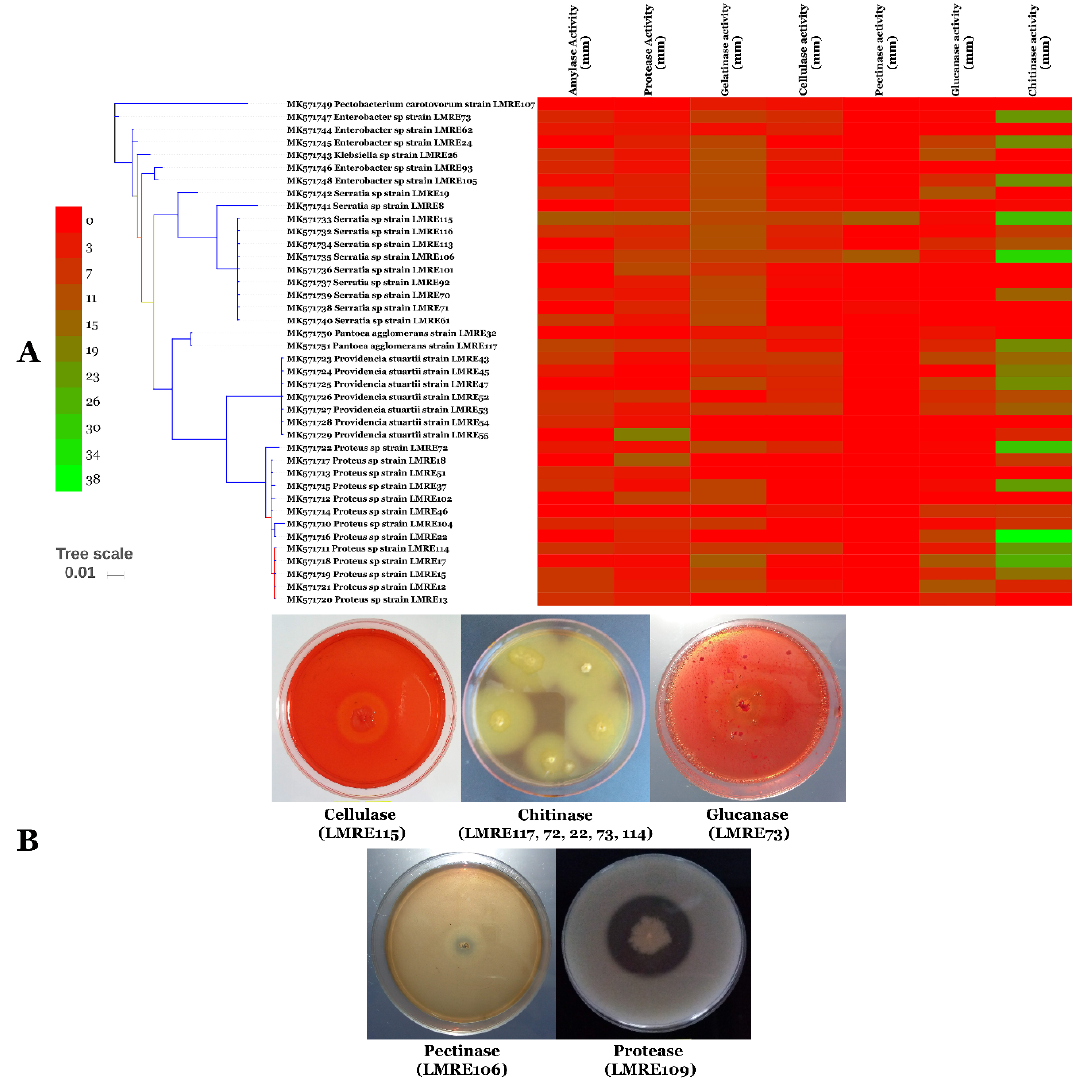
Figure 5. (A) Heat-map and (B) in vitro extracellular enzyme (amylase, protease, gelatinase, cellulase, pectinase, glucanase and chitinase) activity of Gram-negative bacterial isolates. Numbers indicate degradation halo